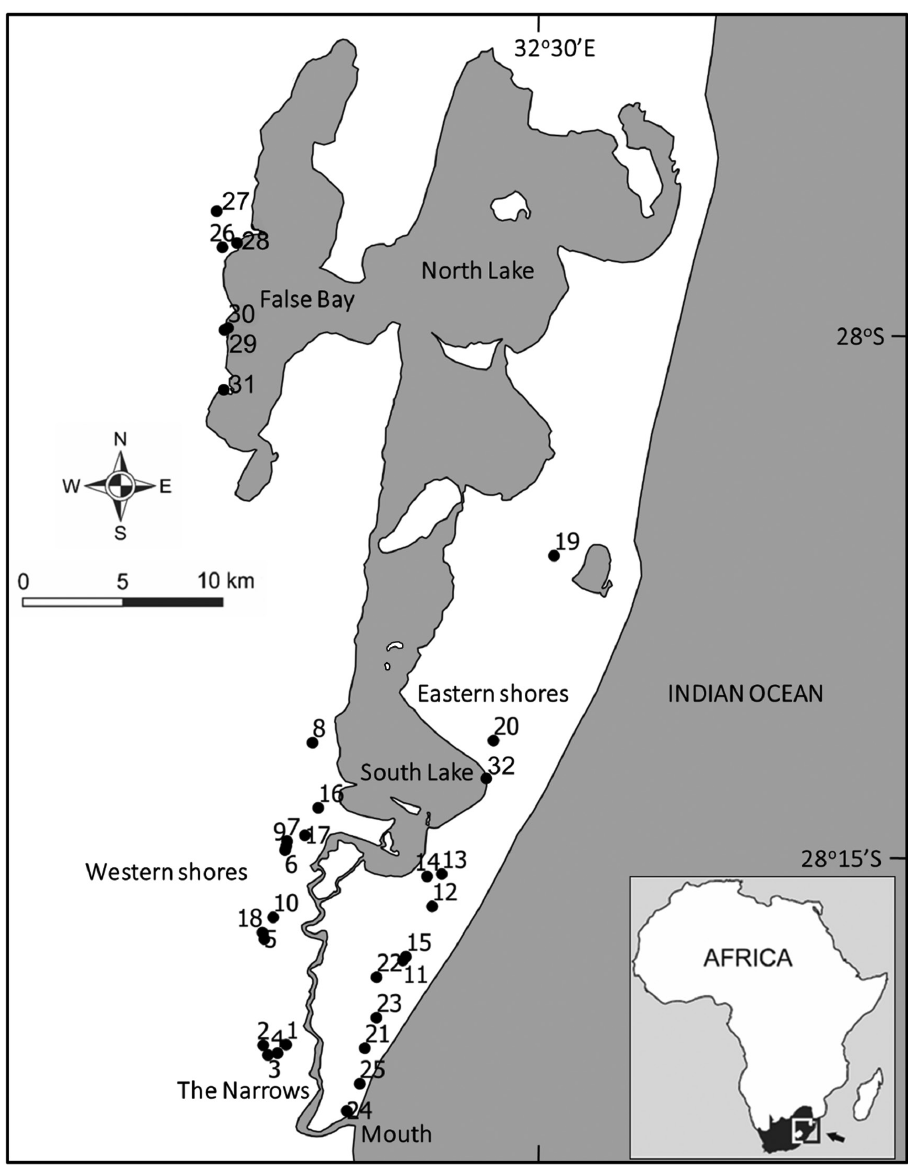
Figure 1. The Lake St Lucia system in northern KwaZulu-Natal. The locations of sites sampled between November 2013 and February 2015 are depicted. Site numbers 1–32 correspond to those in Table 1. Figure reproduced with permission from Perissinotto et al.